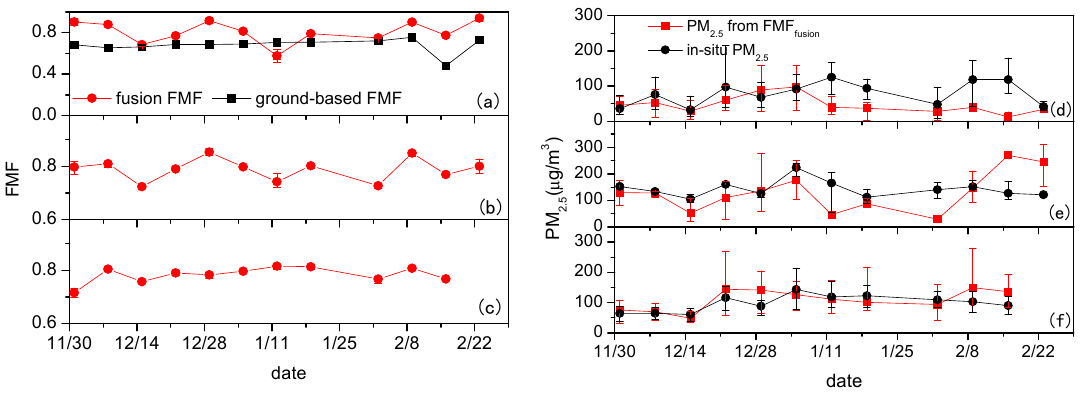
Figure 9. The variabilities of fusion results and ground-based FMF and variabilities of PM 2.5 from in-situ measurements and estimated from fusion results in each region, including the mean, maximum, and minimum value in each region. ( a , d ) are from Region A; ( b , e ) are from Region B; ( c , f ) are from Region C.